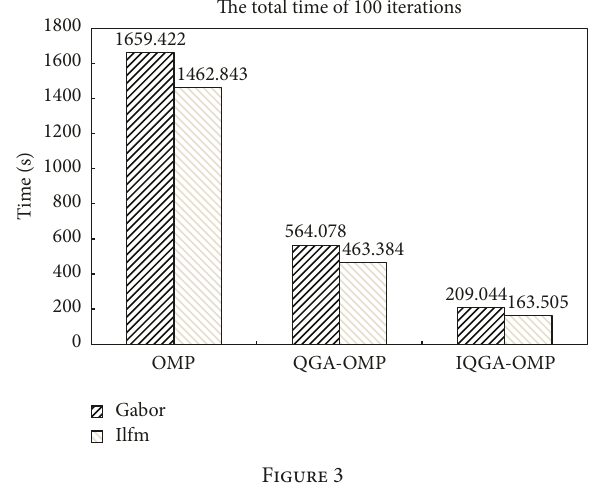
complicated signal for feature extraction in mechanical fault